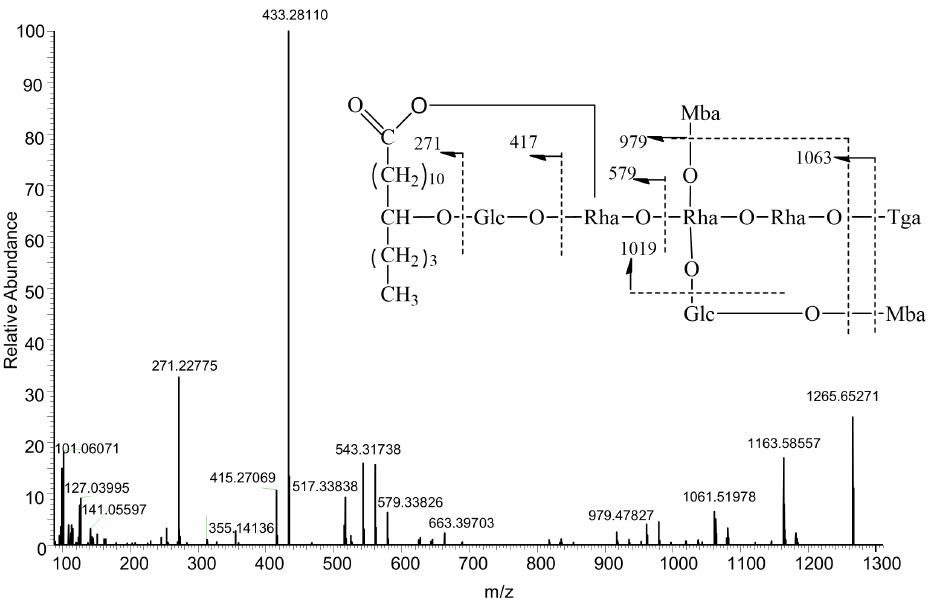
Figure 1. Proposed fragmentation pathway of Turpethic acids C .